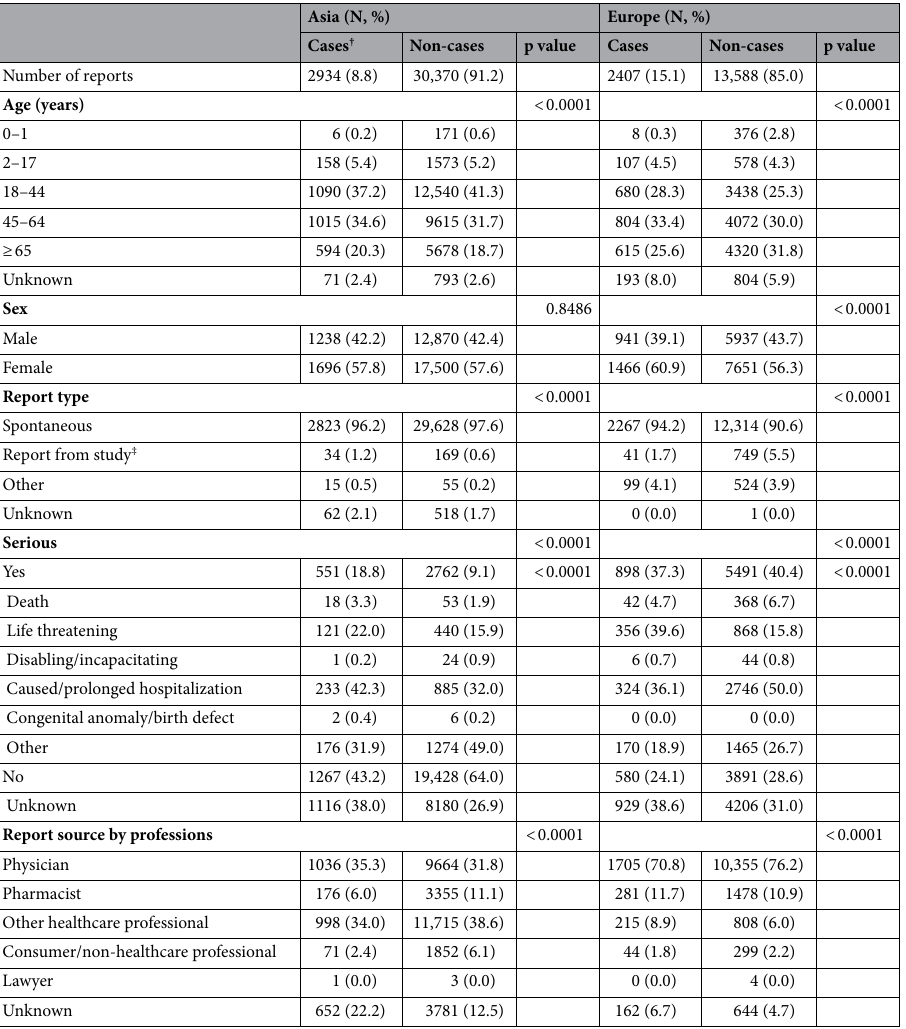
Table 1. Baseline characteristics of all cases and non-cases adverse event reports for propacetamol and other parenteral antipyretics in WHO-UMC VigiBase from 1987 to 2020. AE adverse events, WHO-UMC World Health Organisation-Uppsala Monitoring Centre. † Cases of propacetamol and other parenteral antipyretics that included injection site reaction, dermatitis, eczema, thrombosis, Stevens–Johnson syndrome, and anaphylactic reaction related to MedDRA preferred terms. ‡ Report from study included any AE reports from the previous studies or